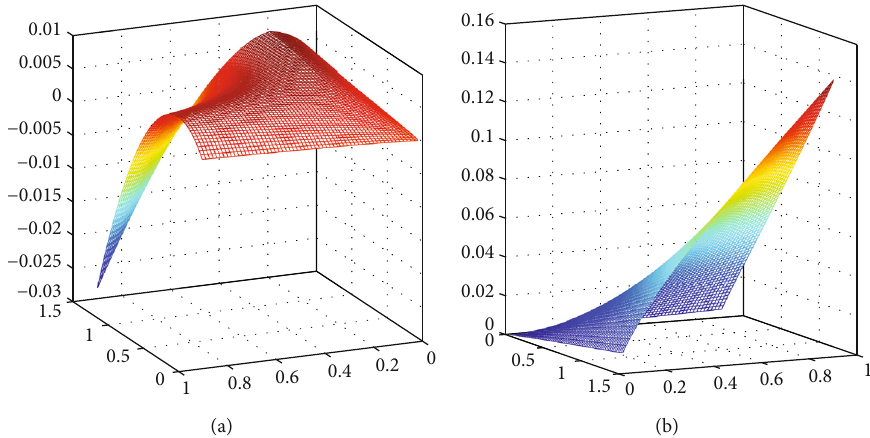
, ϑ T , T = 1 : 5 , T = 0 : 9 , and ν = ð 0 : 9,0 : 7 Þ . The curves of ϑ 1 2 Þ